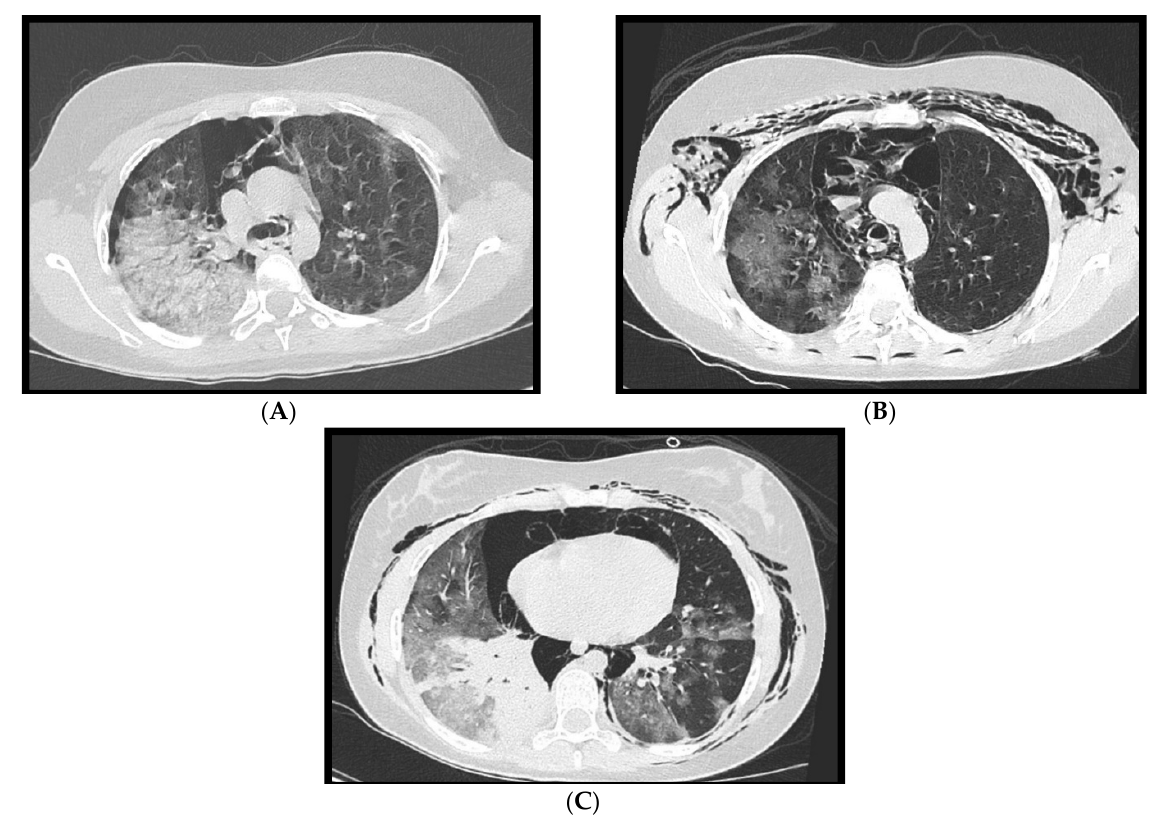
Figure 10. ( A – C ): A 14-year-old girl with spontaneous pneumothorax and pneumomediastinum, in association with extensive ground glass changes. In Figure 10C consolidation of the right lower lobe is noted.